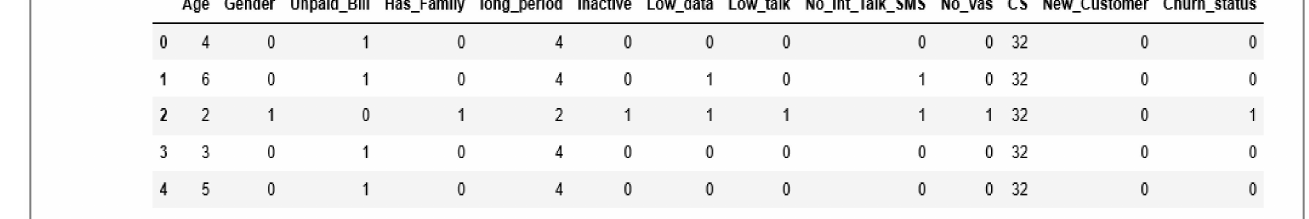
Figure 5. Final dataset after